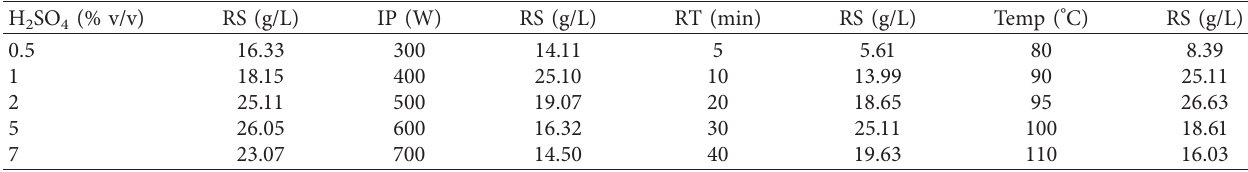
Table 4: The reducing sugar data produced from the delignification process of elephant grass powder followed by acid hydrolysis using microwave irradiation